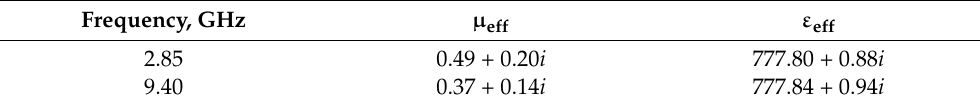
Table 2. The calculated values of the dielectric and magnetic permeabilities of Al micropowder at various frequencies.